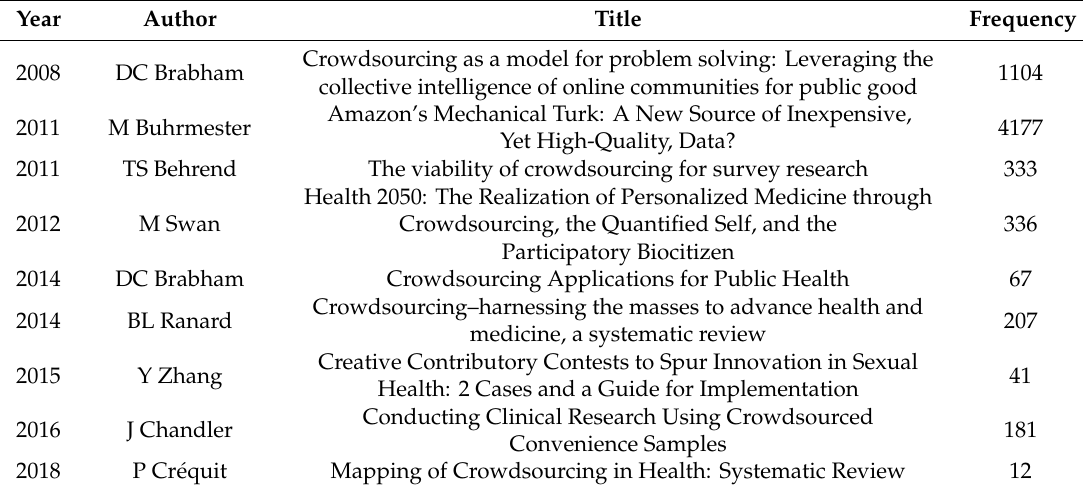
Table 6. Top 10 key references in crowdsourcing applications for public